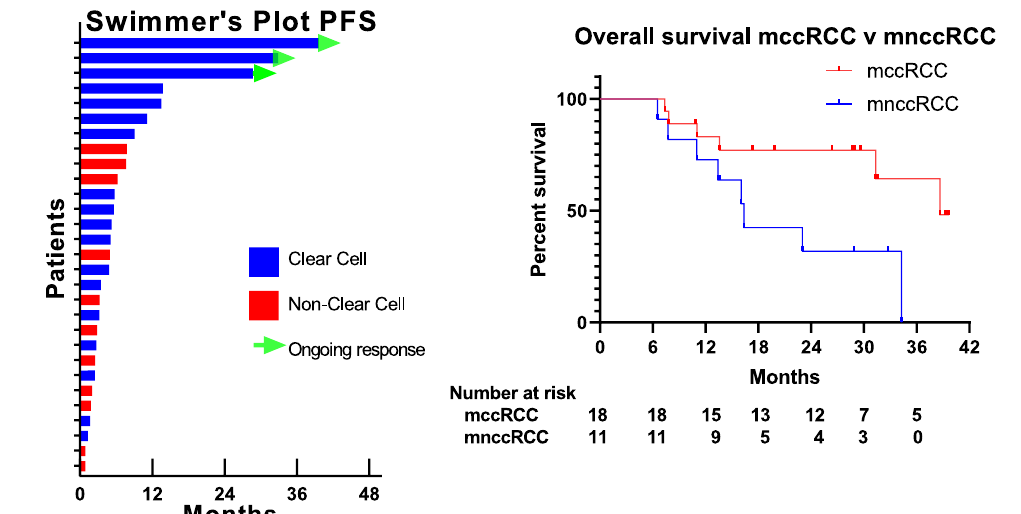
favorable immunological changes in samples from patients with mccRCC. Gene expression analysis showed an increase in CD8 T cells ( p = 0.0008; adj p = 0.0024), B cells ( p = 0.04; adj p = 0.04) and cytotoxic cells ( p = 0.03; adj p = 0.04) in post-treatment tissues of patients with CC histology (Fig. 4a). Similarly, IHC analysis of pre and post-treatment tissues showed a signi fi cant increase in percen- tage of T cells (CD3 + ( p = 0.003; adj p = 0.015) and CD8